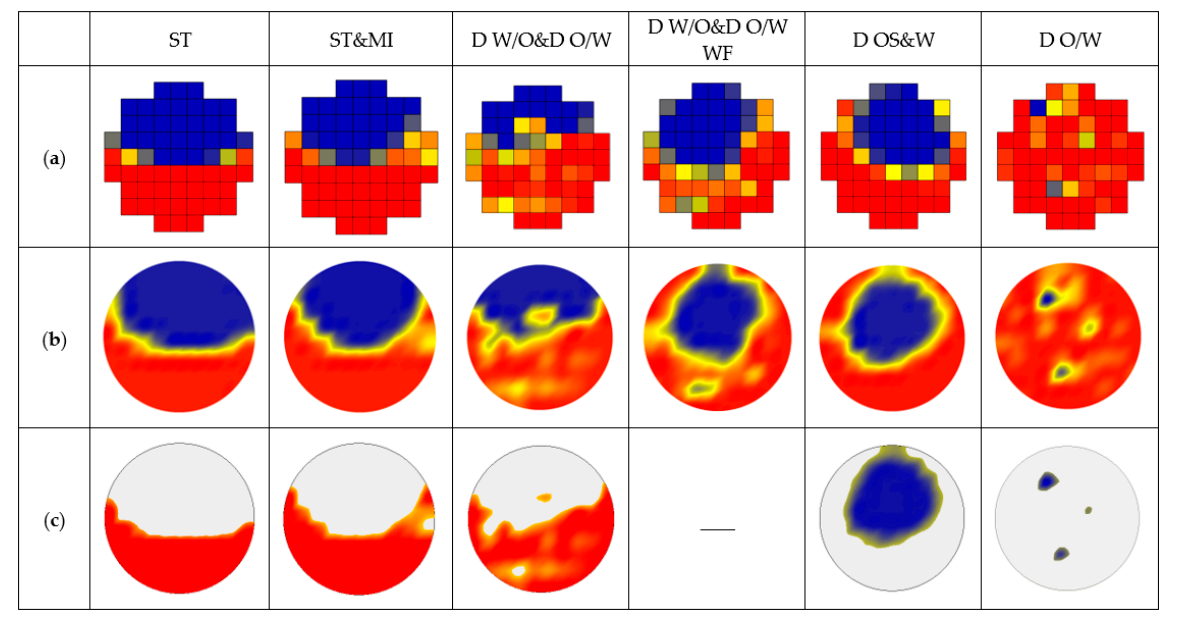
Figure 11. The 2D phase distribution visualized by the sensor: ( a ) Original normalized matrix V N ( k ); ( b ) Interpolation matrix V ip ( k ); ( c ) Matrix V ε ( k ) after threshold processing.